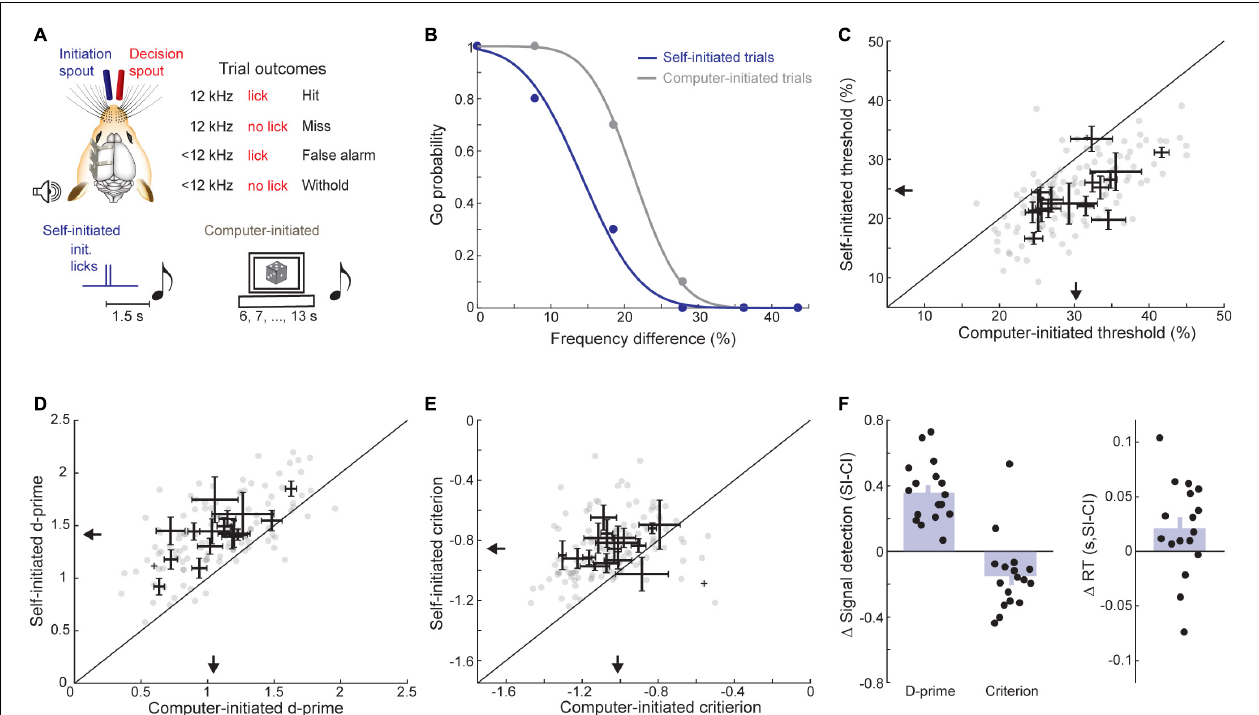
FIGURE 5 | Trial self-initiation enhances frequency recognition thresholds. (A) Task design. Top , schematic of task set-up and contingencies for decision spout licking. Bottom , Target (12 kHz) and foil tones ( < 12 kHz) are presented with predictable timing following contact with the initiation spout (self-initiated, left) or with unpredictable timing determined by the computer (computer-initiated, right). (B) Representative psychometric functions from a single session with interleaved self- and computer-initiated trial blocks. (C) Self-initiated and computer-initiated 50% correct thresholds for frequency recognition. Each gray dot represents one behavioral session. Bidirectional error bars show mean ± 1 S.E.M. self-initiated and computer-initiated thresholds for each mouse. Arrows indicate group medians. (D) D-prime value, plotted as in panel (C) . (E) Criterion values, plotted as in panel (C) . (F) Quantification of mean changes in sensitivity, criterion, and reaction time between self-initiated and computer-initiated trials. Each black dot represents one subject and bars reflect the mean ± 1